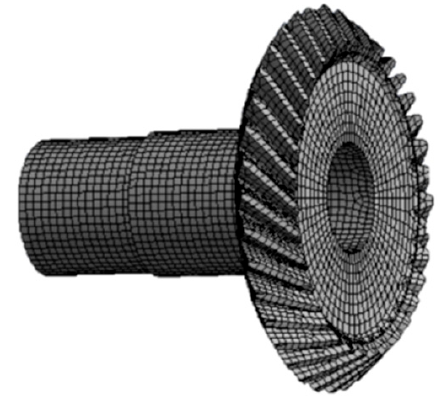
Figure 11. FEM model of bevel gear.